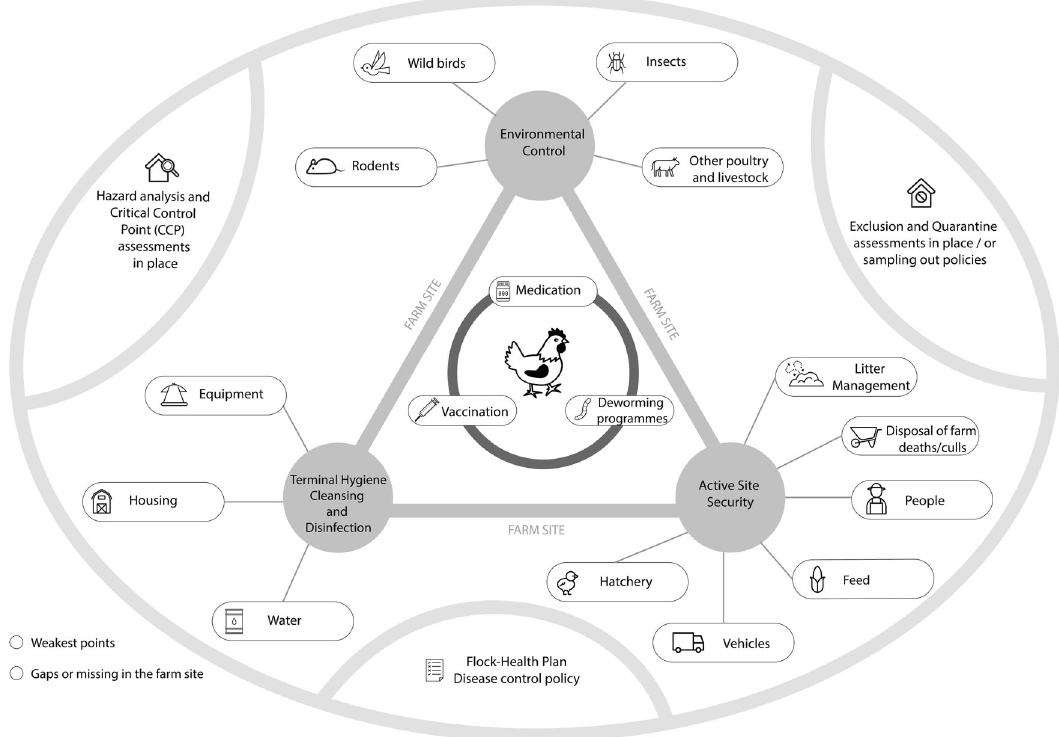
Fig. 2 The fi rst version of the Disease Control Map. We used a version of this map with stakeholders at the PCVC